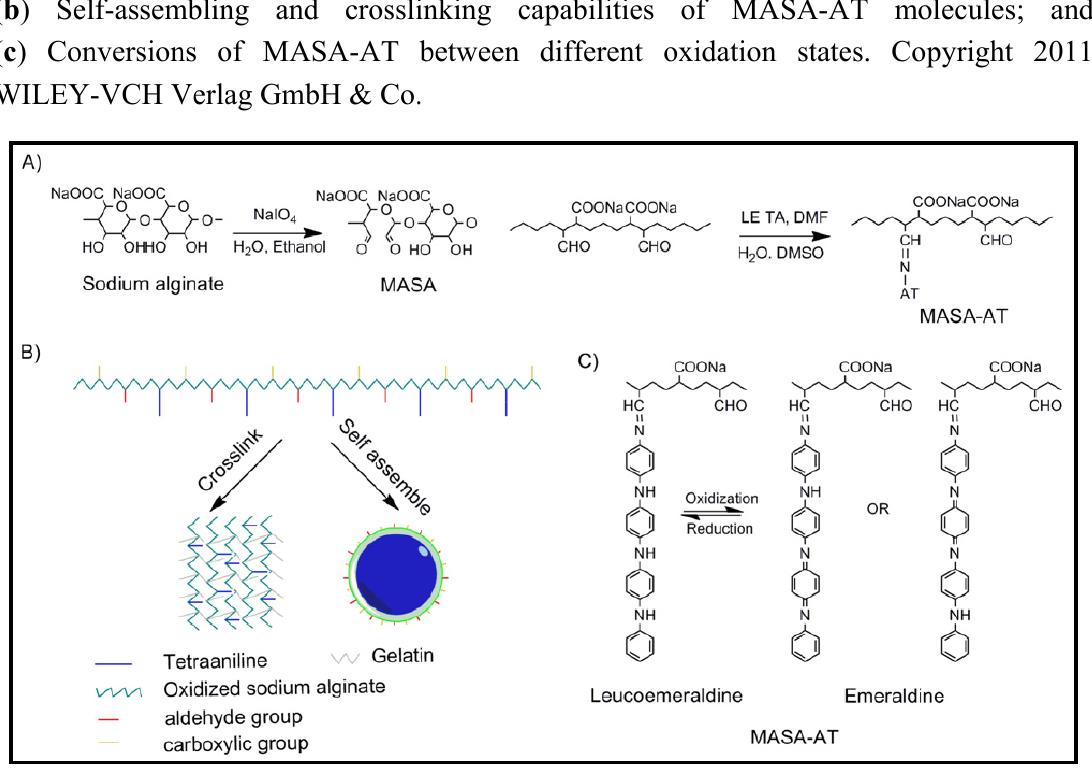
Figure 9. ( a ) Scheme based on [43] showing the synthesis of the multialdehide sodium alginate (MASA) and the tetraaniline- graft -multialdehide sodium alginate (MASA-AT); ( b ) Self-assembling and crosslinking capabilities of MASA-AT molecules; and ( c ) Conversions of MASA-AT between different oxidation states. Copyright